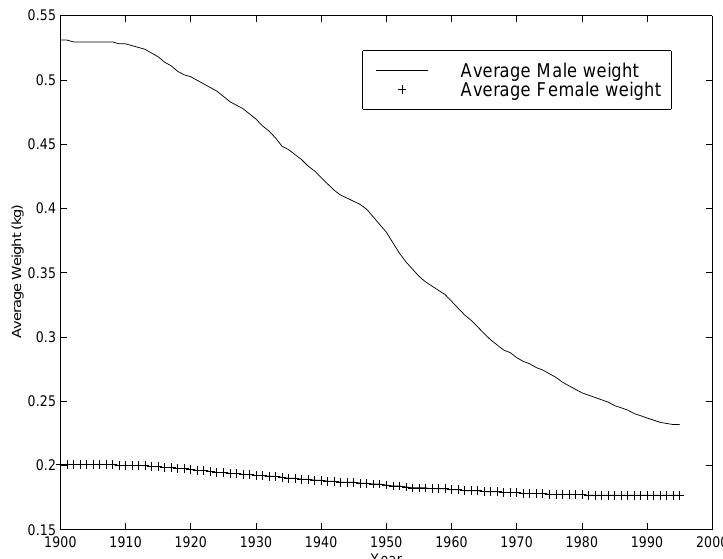
Figure 5: Calculated average male and female weight time series for the Cape Rock Lobster resource given in